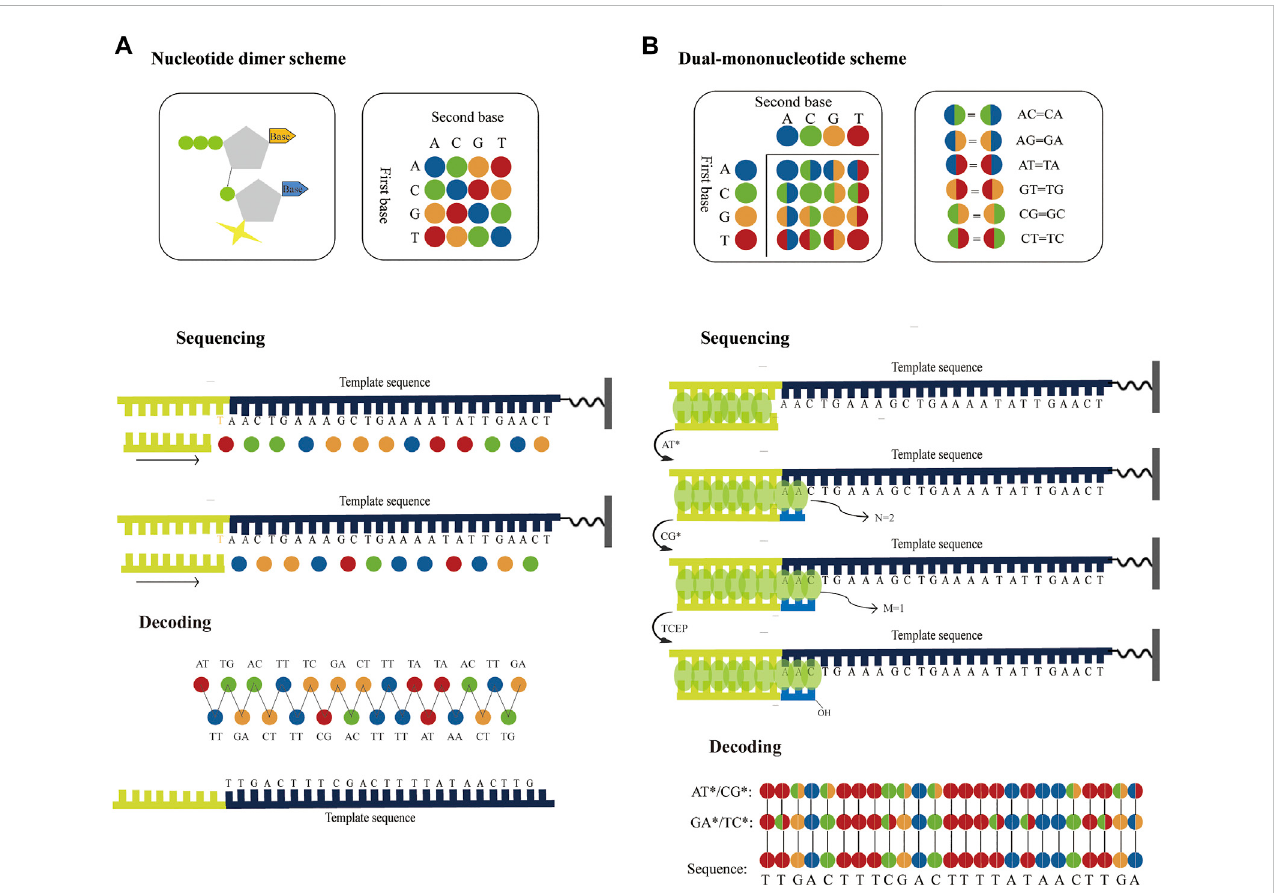
FIGURE 6 Possible strategies to improve the accuracy of the surface fl uorescence sequencing platforms based on chip ampli fi cation. (A) Application of dual-base sequencing on the surface fl uorescence sequencing platforms based on chip ampli fi cation. The four different fl uorophores represent 16 nucleotide dimers, respectively.ThenucleotidedimercomplementarytothetemplateisincorporatedusingDNApolymeraseandisimagedtoidentifythesetwobases.Thenthe fl uorophoreiscleavedoffandanotherroundofextensionbegins.Thiscycleisrepeatedseveraltimesuntilthecompletetemplateissequenced.Another round of sequencing occurs with a primer that has one base longer than the previous primer. Therefore, two sets of four-color codes can be obtained from two parallel runs, from which the sequence information can be then decoded. (B) Application of the correctable decoding sequencing on the surface fl uorescence sequencing platforms based on chip ampli fi cation. The number of incorporated nucleotides in each extension reaction is determined by quantitative staining double-stranded DNA with fl uorescent dyes. In the fi rst extension reaction, a mixture of AT* is added to the primed DNA template. DNA polymerase incorporates two bases to pair the fi rst two bases and generates two fl uorescent intensities. Next, another mixture of CG* is added to the second extension reaction, one base is paired with the next one base to generate one fl uorescent intensity. The template sequence information can be deduced through two parallel runs using different dual-base